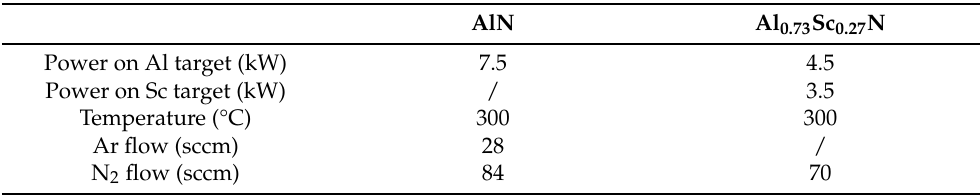
Table 1. Sputter deposition parameters of AlN and Al 0.73 Sc 0.27 N thin